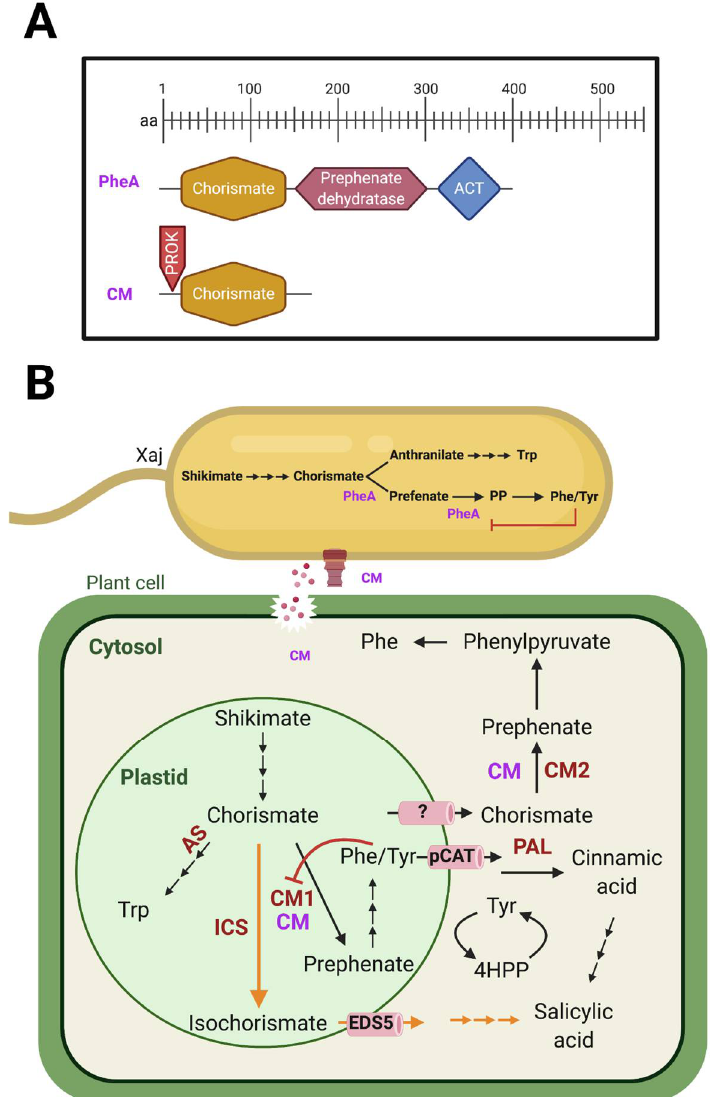
Figure 1. ( A ) Bacterial PheA and CM domain composition. ( B ) Shikimate pathway in phytopathogens and plants. Red: plant enzymes. Purple: bacterial enzymes. PheA: prephenate dehydratase; Trp: tryptophan; PP: phenylpyruvate; Phe: phenylalanine; Tyr: tyrosine; CMs: secreted chorismate mutase; AS: anthranilate synthase; ICS: isochorismate synthase; CM1: plastidic chorismate mutase; CM2: cytosolic chorismate mutase; pCAT: plastidial cationic amino acid transporter [7]; EDS5: enhanced disease susceptibility 5 [8]; PAL: phenylalanine ammonia-lyase; 4HPP: 4-phenylpyruvate. In this model the bacterial secreted CM augments prephenate synthesis, while consuming precursors of salicylic acid, thus dampening plant immunity. Created in BioRender.com with information from Djamei et al. 2011, Qian et al. 2019, and Lefevere et al. 2020 [5,7,8].